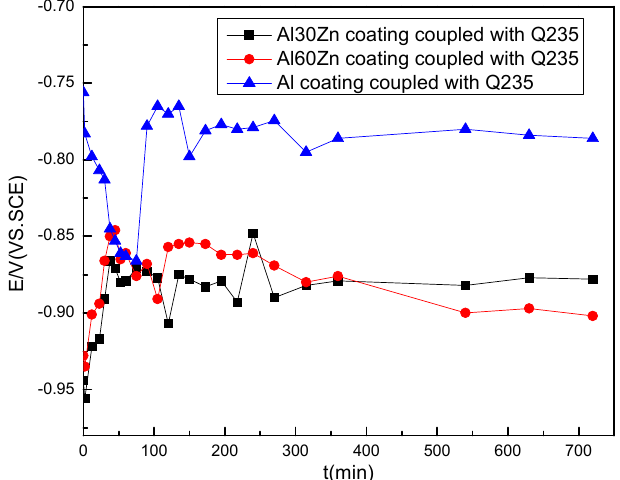
Figure 10. Variation of mixed polarized potential of Q235 steel coupled with different AlZn coatings with time in seawater.